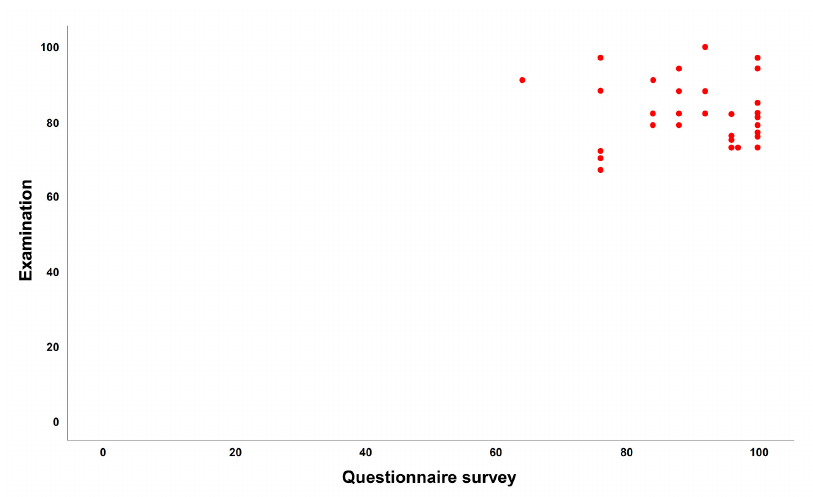
Figure 6. Scatterplot showing the association between survey and examination.